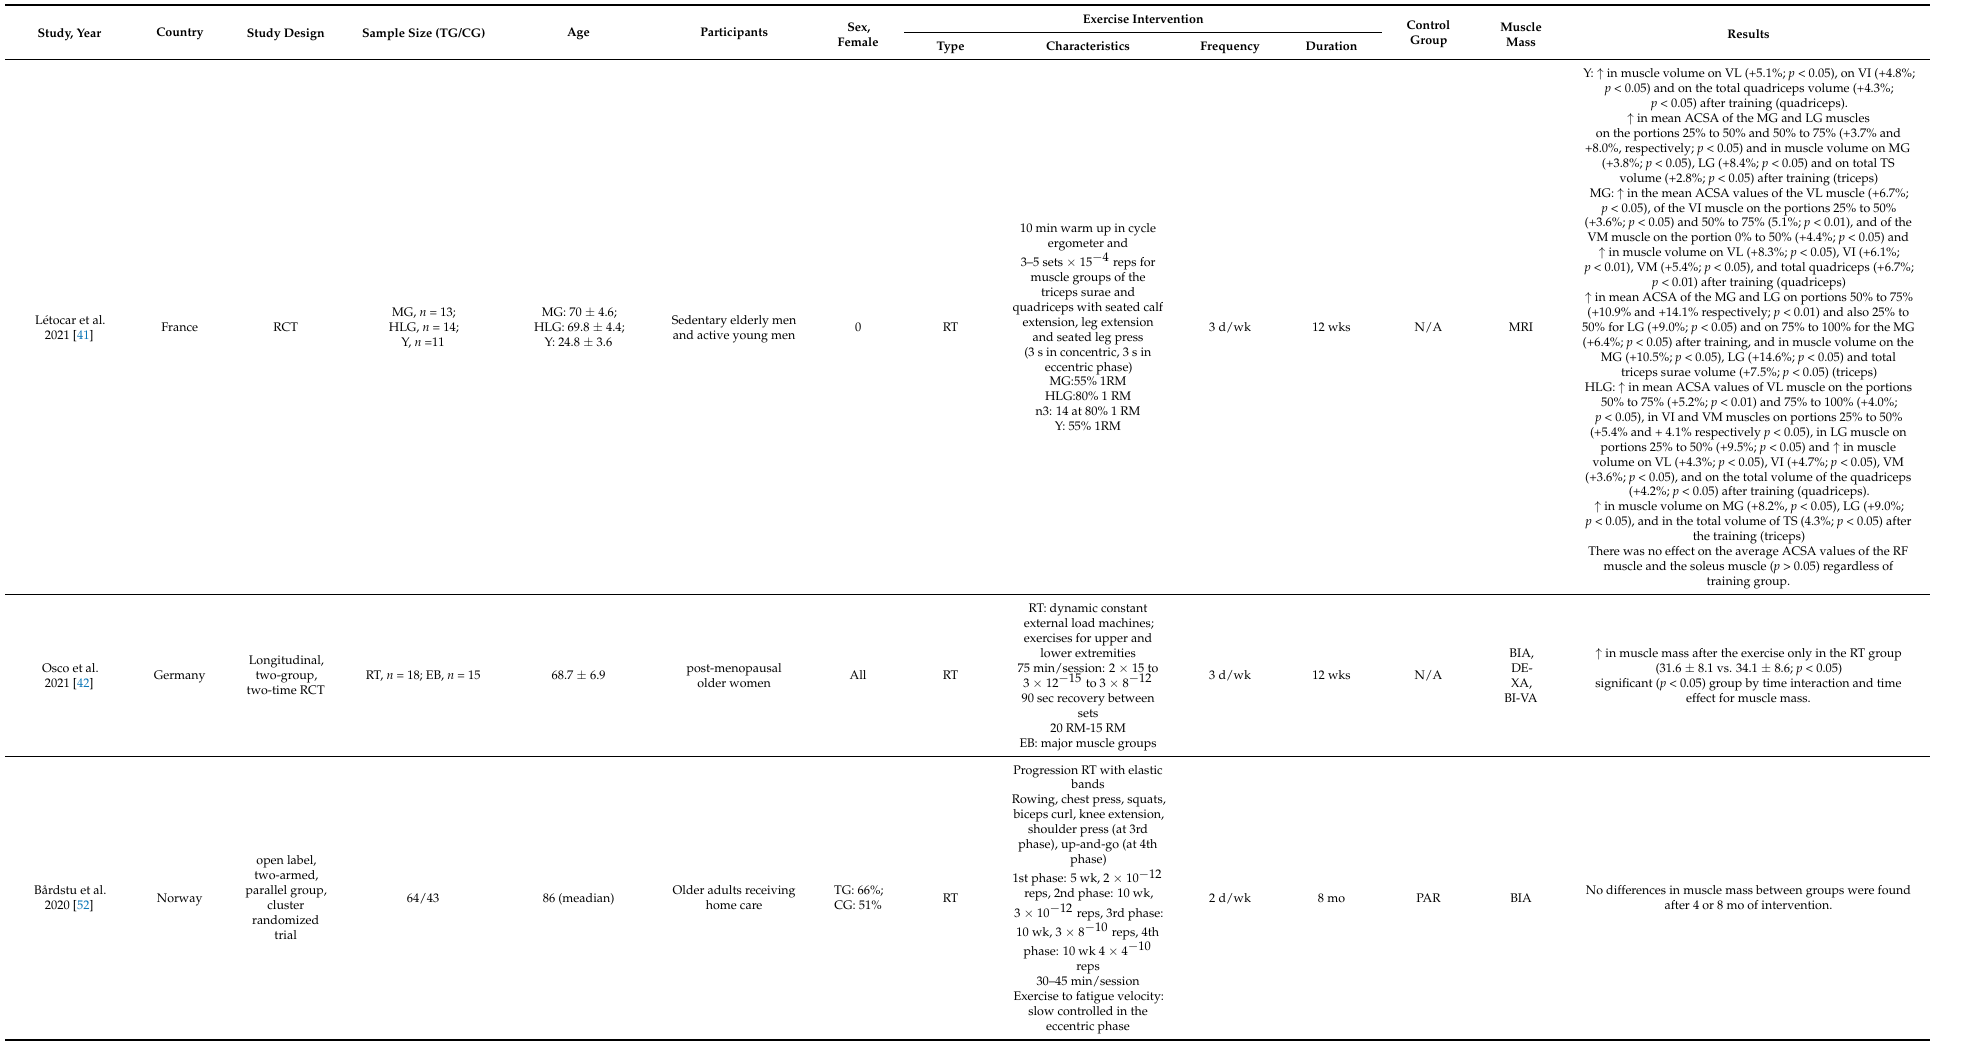
Table 1. Patients